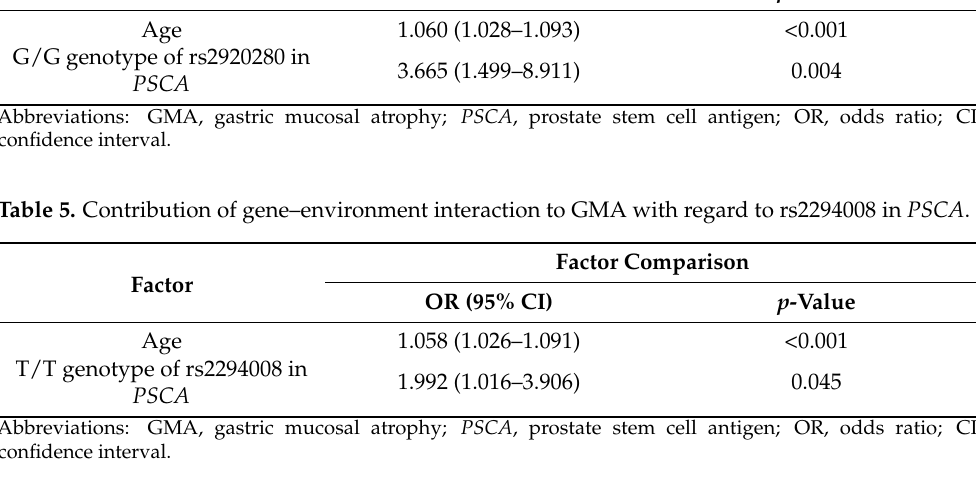
Table 4. Contribution of gene–environment interaction to GMA with regard to rs2920280 in PSCA . Factor